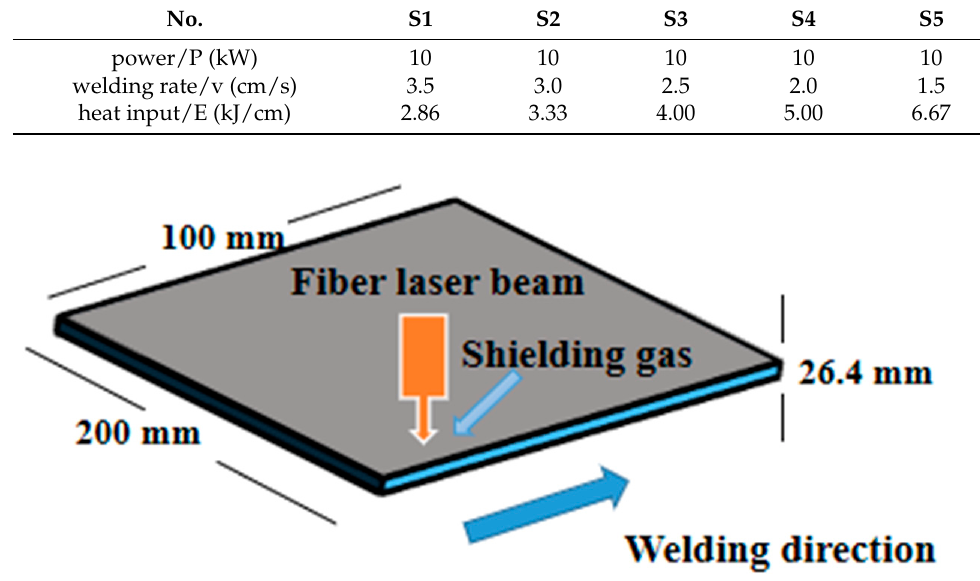
Figure 1. Schematic diagram of fiber laser welding. Table 1. The specific experimental parameters in the laser welding procedures.